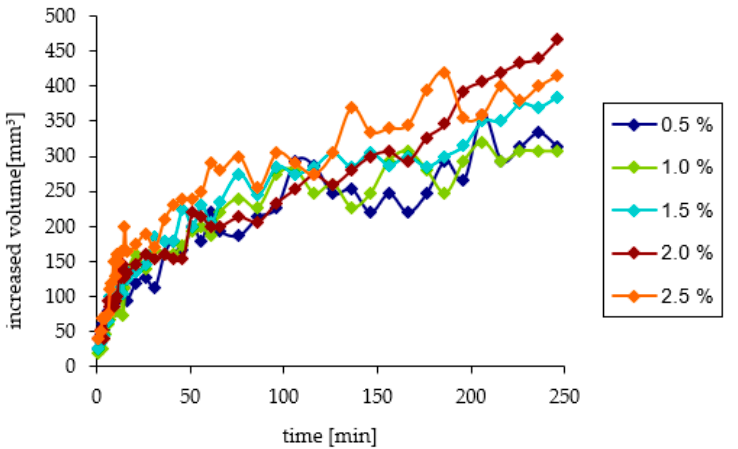
Figure 4. The course of changes in the penetrated volume of the model skin sebum under the influence of AMPD solutions with various concentrations within 240 min.